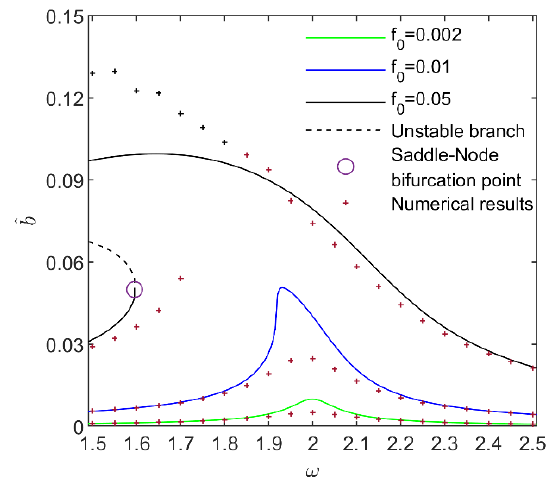
x ± , 0) with the change of ω . Figure 5. Variation of the amplitude of periodic solution near ( ± x Figure 5. Variation of the amplitude of periodic solution near ( c , 0) with the change of ω . c Based on the analysis of the periodic responses near the origin and the nontrivial equilibria, the evolution of the periodic solutions of system (5) with the amplitude of f 0 for ω = 1.5 is illustrated in Figure 6. Obviously, when f 0 increases from 0, the nontrivial equilibria and the origin lose their stability; instead, three periodic attractors coexist, attributed to the disturbance of the tristable equilibria. When f 0 varies from 0 to 0.02, the numerical simulation is in great agreement with the theoretical solution. However, when f 0 continues to increase, the theoretical prediction of the periodic responses does not match the numerical results well, which may be due to the limitation of the Method of Multiple Scale, namely the value of the excitation frequency ω should be closed to the inherent frequency of the perturbed systems (12) and (28) near the origin and the nontrivial equilibria ( ± x c , 0). Actually, the given value of the excitation frequency is ω = 1.5, while the inherent frequencies of the systems (12) and (28) are 1 and 2, respectively. It means that the derivations of ω from the two inherent frequencies are not that small. Although the prediction is not that quantitatively accurate,